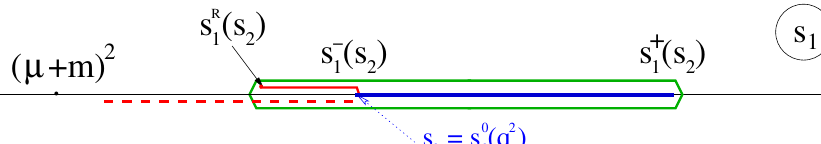
Figure 7. Singularities of the function ∆ ( q 2 , s 1 , s 2 ) in the complex s 1 plane as a function of s 2 for q 2 > 0. ( s ) (This corresponds to the external s 2 and the internal s 1 integration). The plot shows the trajectory s R 2 1 ( s ) moves on the unphysical sheet (dashed red vs s 2 at fixed q 2 > 0: for s 2 < s 0 , the branch point s R 2 2 1 ( s ) through the normal ( s ) travels around the branch point s − line). However, as soon as s 2 > s 0 , s R 2 2 2 1 1 ( s ) , s + ( s )] , appears on the physical sheet, and further moves to the left from s − ( s ) (solid red cut [ s − 2 2 2 1 1 1 line). Respectively, for s 2 < s 0 , the integration contour in the complex s 1 -plane may be chosen along 2 ( s ) , s + ( s )] . For s > s 0 ( s ) , and the interval [ s − , however, the contour should embrace the point s R 2 2 2 2 2 1 1 1 therefore the integration contour (green line) contains two segments: the “anomalous” segment from ( s ) (solid red line), and the “normal” segment from s − ( s ) to s + ( s ) (blue line). The real ( s ) to s − s R 2 2 2 2 1 1 1 1 axis of the variable s 1 is shown as black line.